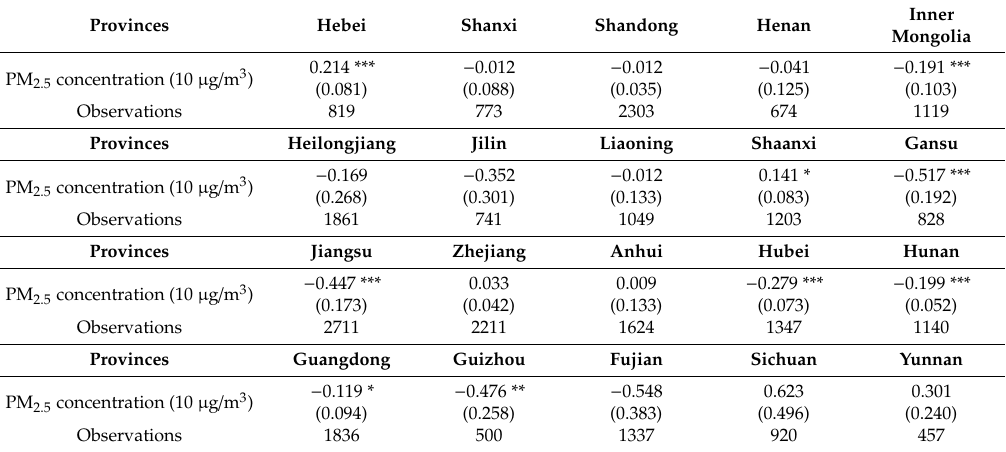
Table 6. The impact of smog on the second birth intention of the floating population in major provinces in China. Provinces Hebei Shanxi Shandong Henan